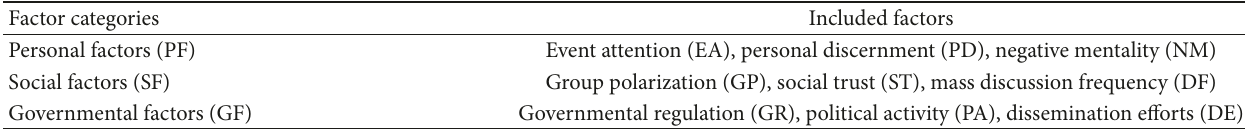
Table 1: Rumor-driven